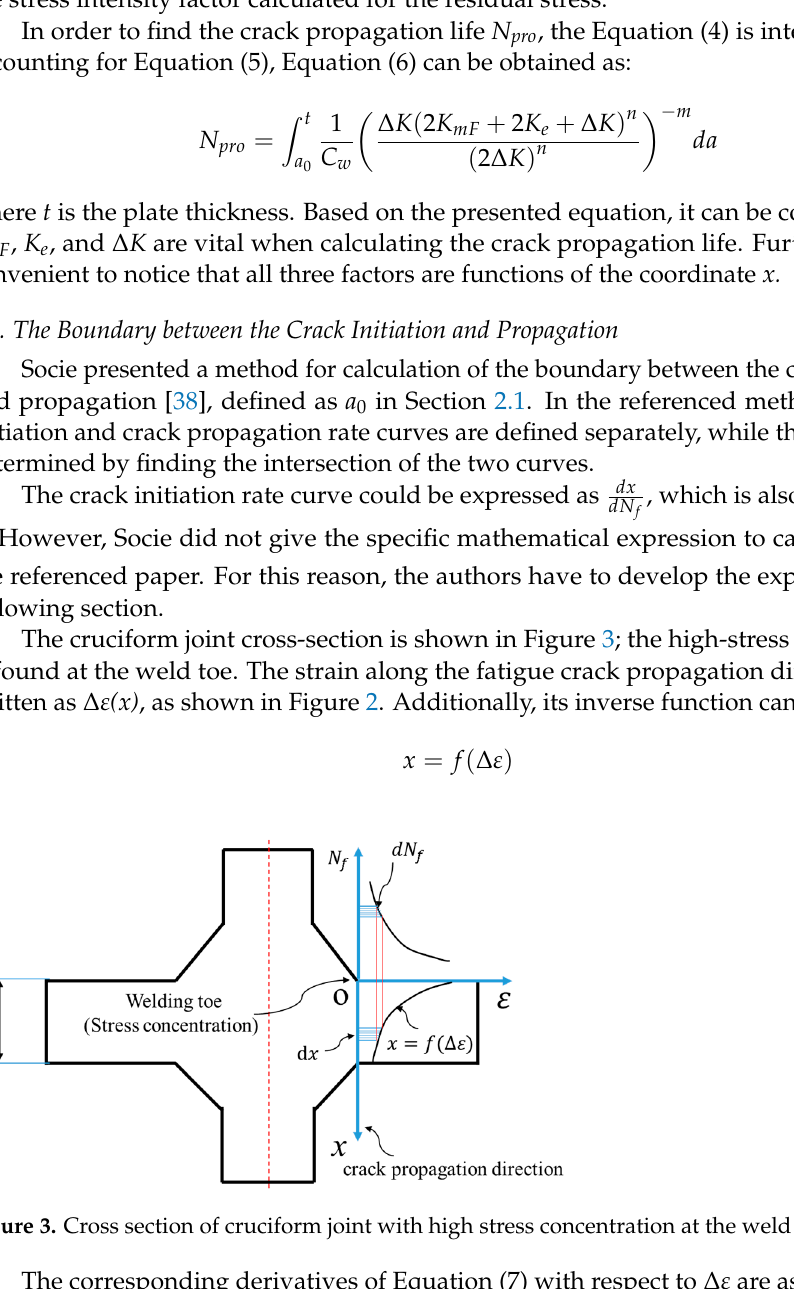
Figure 4. The boundary between the crack initiation and propagation determined by the initiation mechanisms and the propagation mechanisms. 2.4. Stress Concentration Model of the Crack Initiation and Propagation Stages 2.4.1. Stress in the Vicinity of Weld Toe Under the Tensile Load The plane strain finite element model based on ABAQUS 6.13 have been es- tablished (shown in Figure 5) using the CPE8R finite elements. The cruciform joint plate thickness was set to 10 mm, and the welding fillet size is 13 mm, which is greater than the plate thickness to guarantee weld toe failure in fatigue assessment [2]. Grid density was increased and set to 0.01mm at weld toe notch because the size of the crack initiation stage is very small.